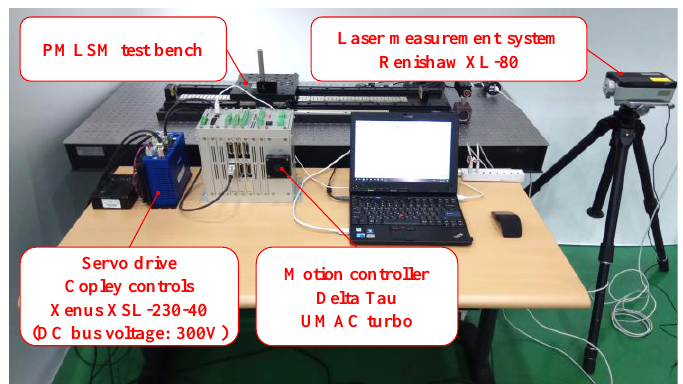
Figure 13. Test setup for servo performance evaluation.